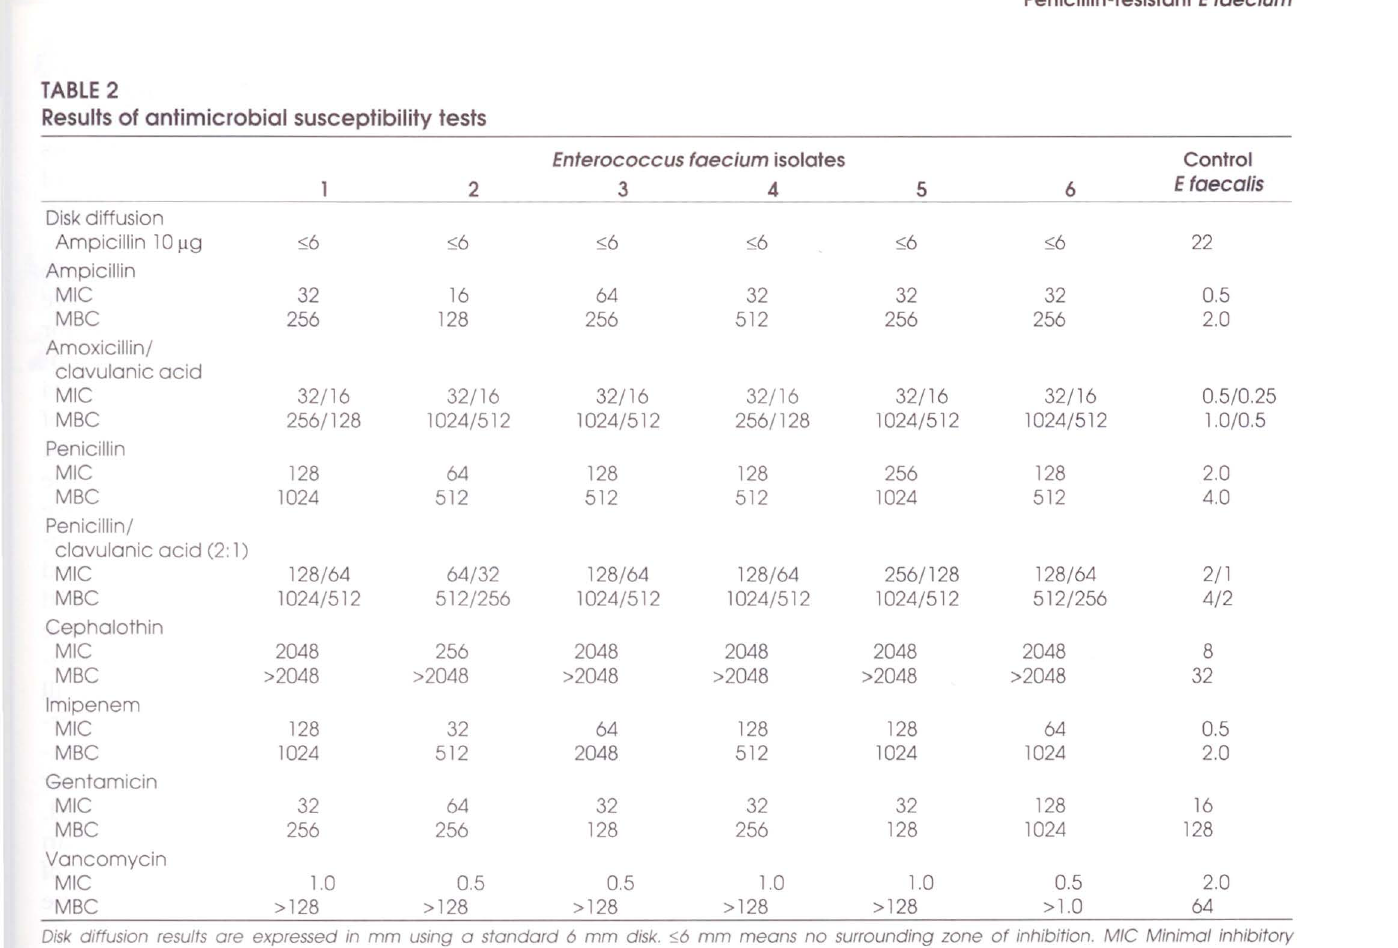
Enterococcus faecium